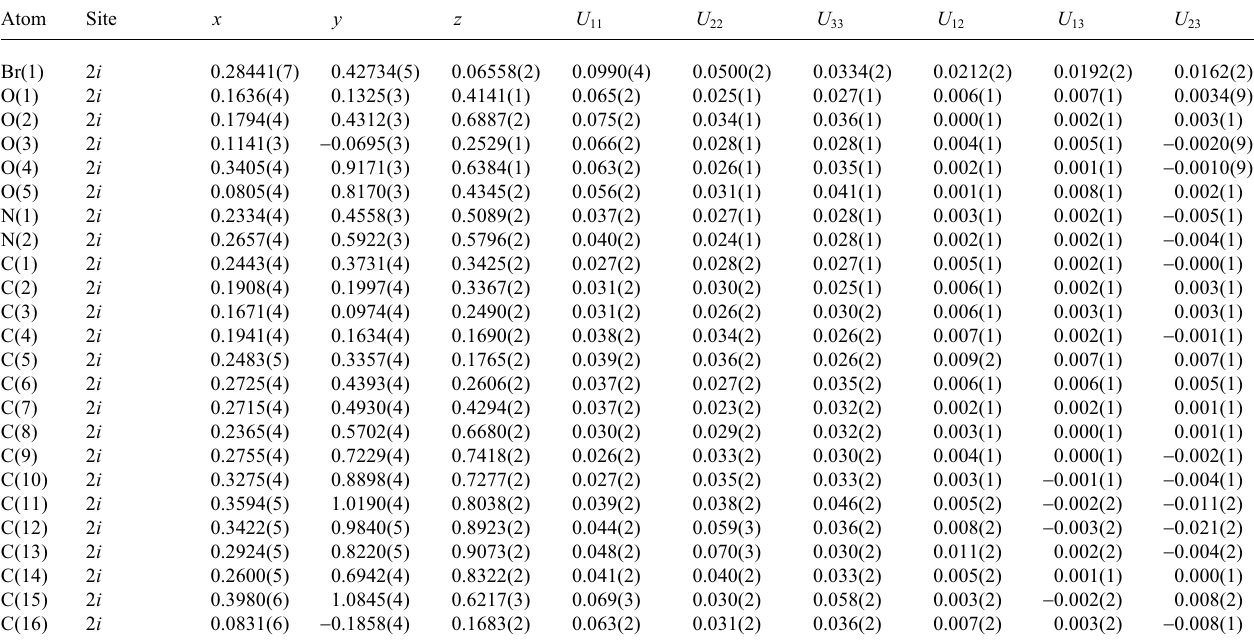
Table 3. Atomic coordinates and displacement parameters (in Å 2 )